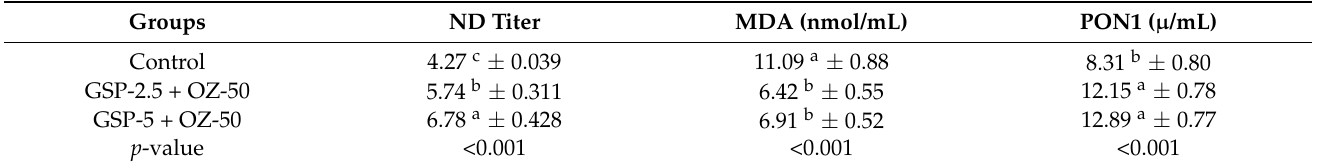
Table 6. Effect of dietary grape seed powder and zinc–glycine chelate on antibody titer against Newcastle disease (ND), malondialdehyde (MDA), and paraoxonase (PON1) in broiler chicks under summer stress conditions.